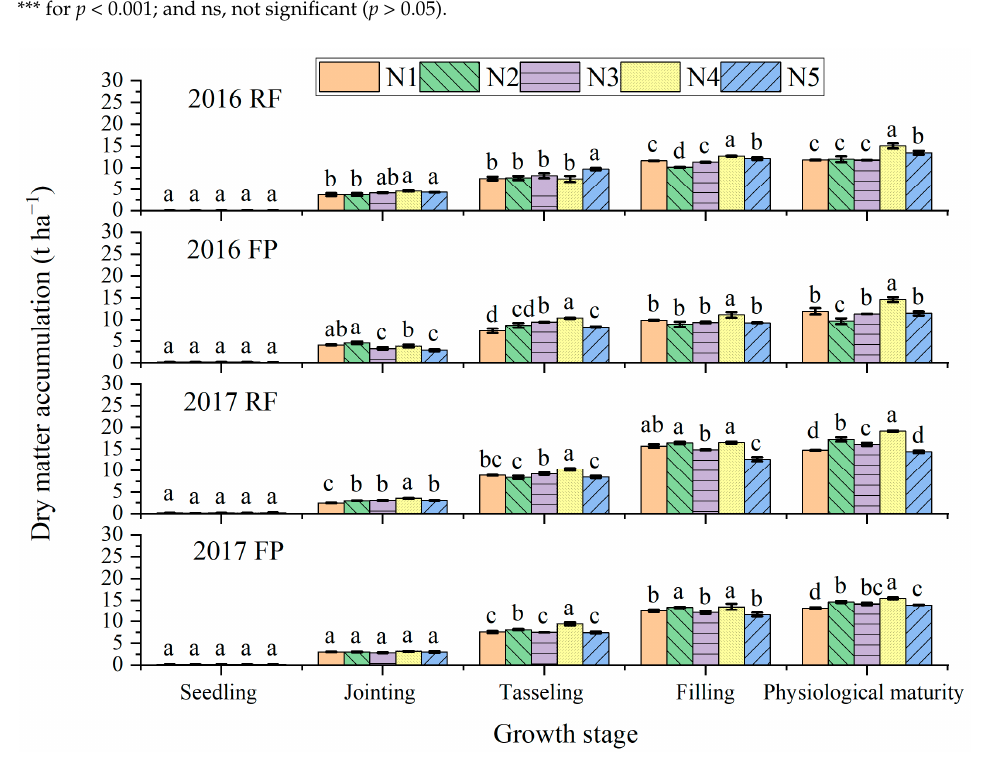
Figure 4. Effects of different cultivation practices and nitrogen formulas on dry matter accumulation in 2016 and 2017. RF, ridge–furrow plastic film mulching; FP, flat planting with plastic film mulching; N1, N2, N3, N4, and, N5 treatments are explained in Table 2. Bars show mean values plus one standard error ( n = 3). Different lowercase letters above the bars indicate that the difference was significant at p < 0.05 under LSD test.